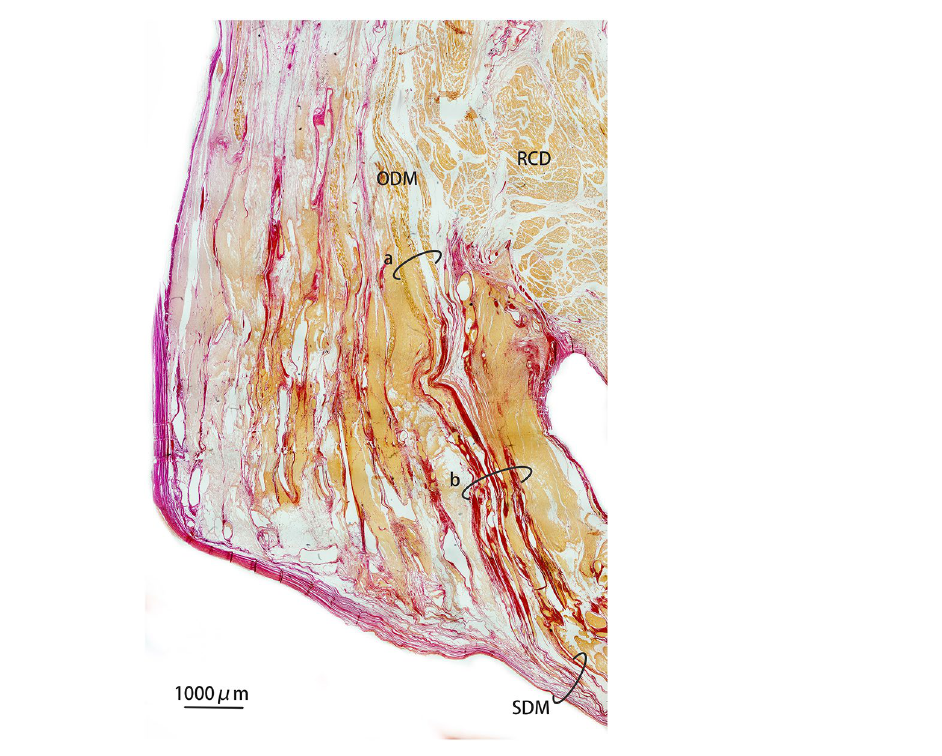
: fused vertebral body of the first ★